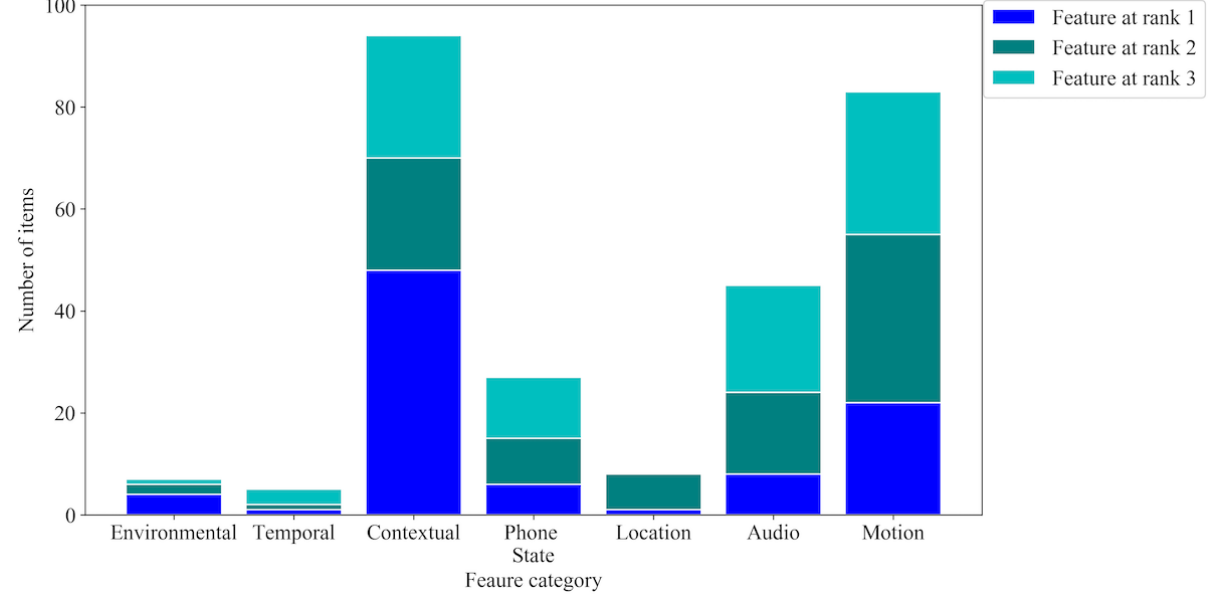
Figure 5. Importance of feature categories for emotional transition detection. The color-coded portions of each category represent their contributions to the top 3 ranks of features of 18